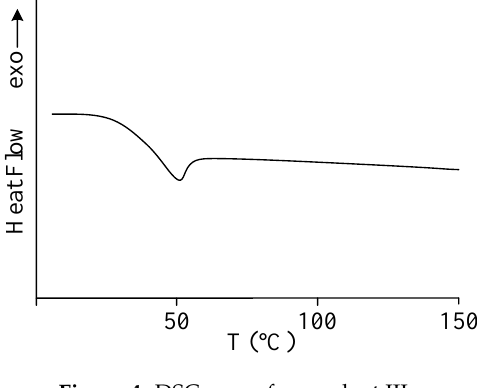
Figure 4. DSC curve for product III.